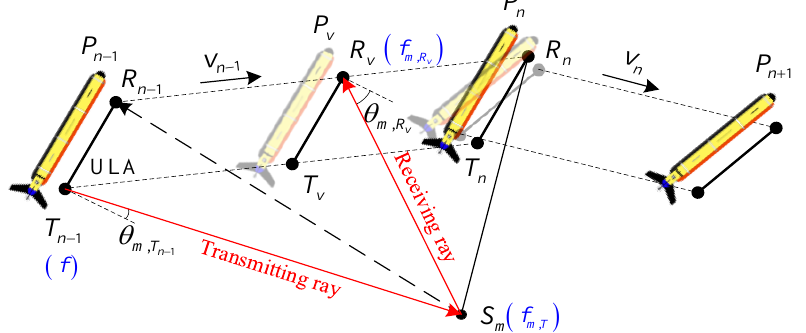
Figure 5. Scanning process in the polyline path model.